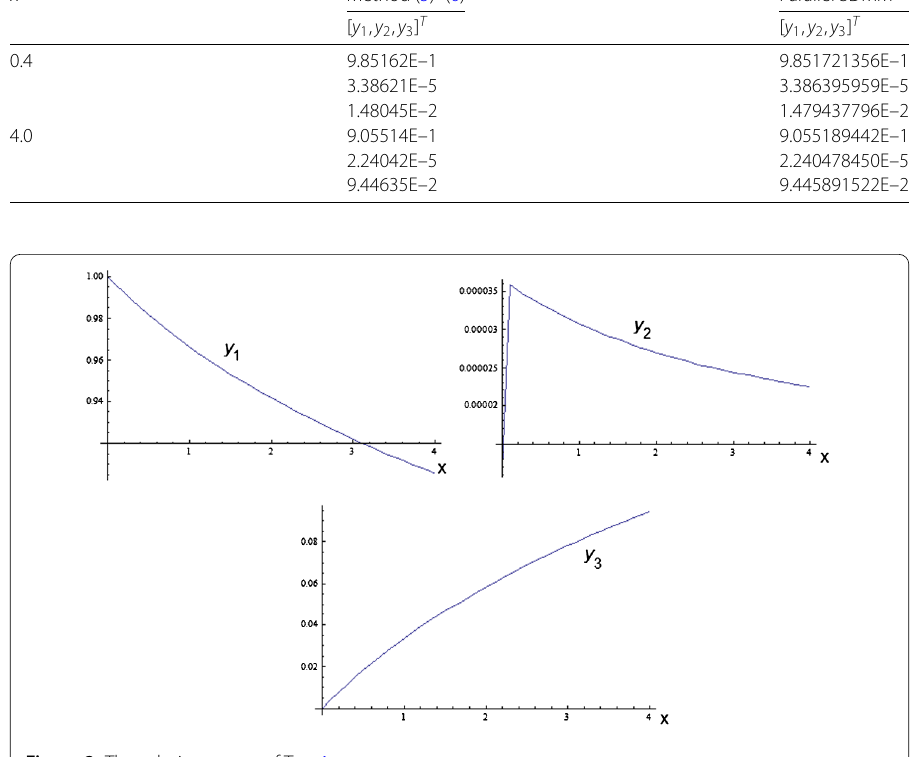
Figure 2 The solution curves of Test